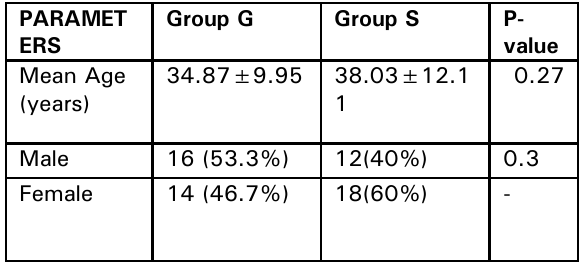
Table 1: Comparison of Patient’s Characteristics: We noted that there were no significant differences between two groups in terms of age, sex and weight. The demographic data are shown in Table 1.